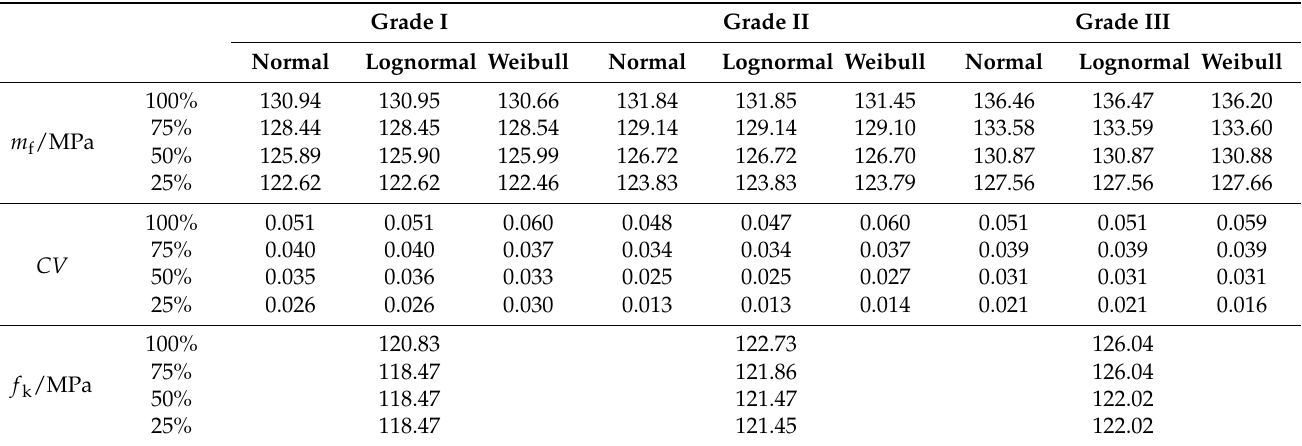
Table 2. Bending strength